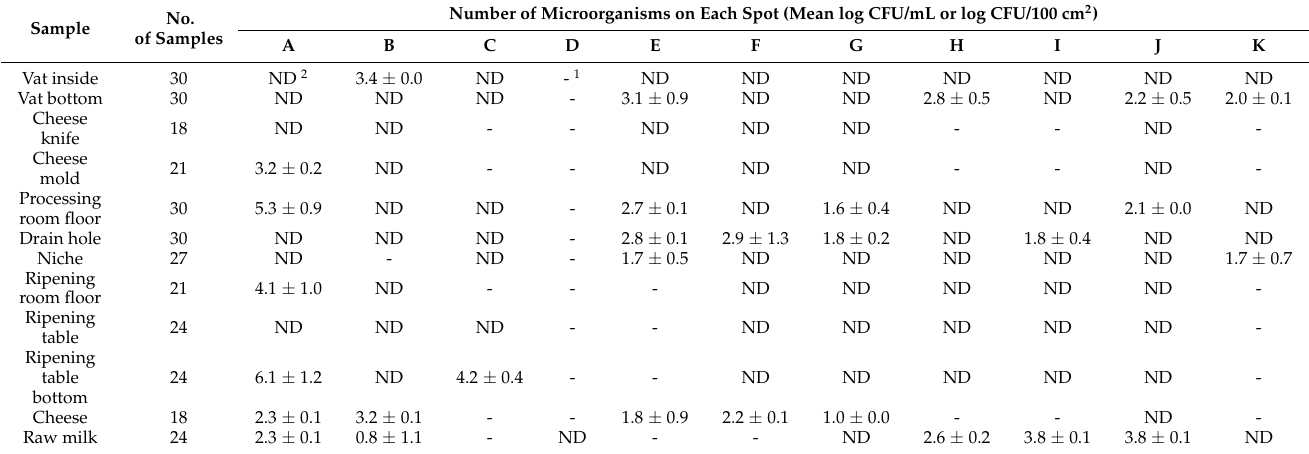
table bottom. In raw milk and cheese, the contamination was 0.8~3.8 log CFU/mL and 1.0~3.2 log CFU/g, respectively. Table 9. Mean ( ± SD) coliform counts in the processing plants of each dairy farm (A to K). No. Sample of